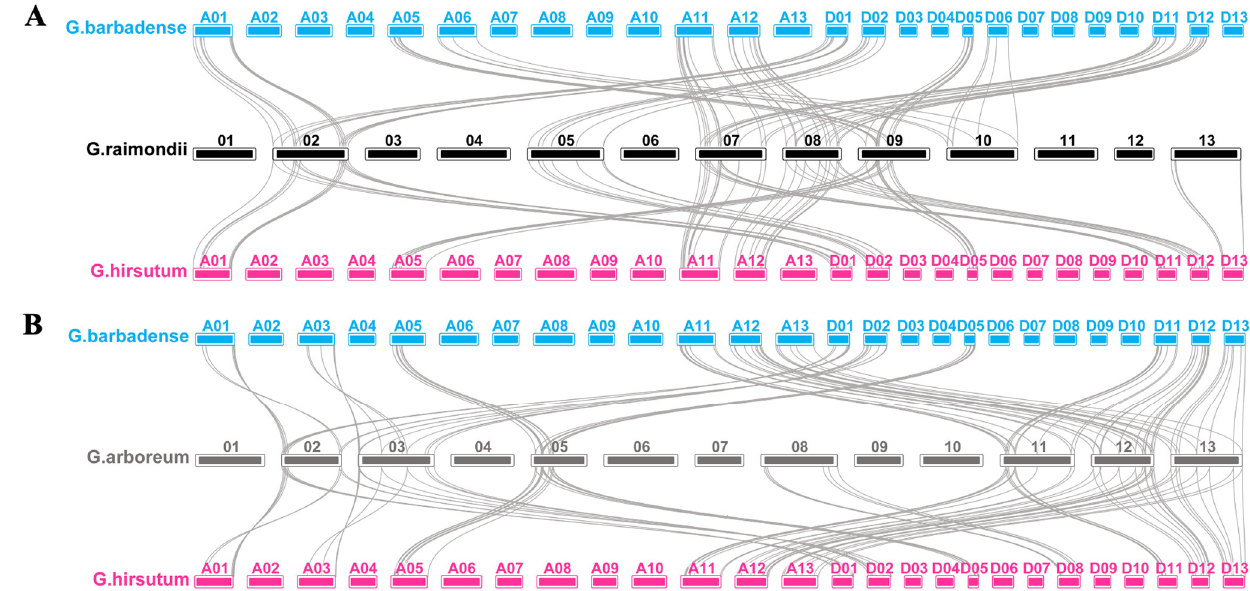
Figure 2. Collinearity analysis of bZIP genes between diploid and tetraploid cotton. ( A ) Collinearity analysis between G. hirsutum , G. barbardense , and G. raimondii . ( B ) Collinearity analysis between G. hirsutum , G. barbardense , and G. arboretum . Blue, magenta, black, and gray boxes represent chromo ‐ somes in G. barbardense , G. hirsutum , G. raimondii , and G. arboretum ,